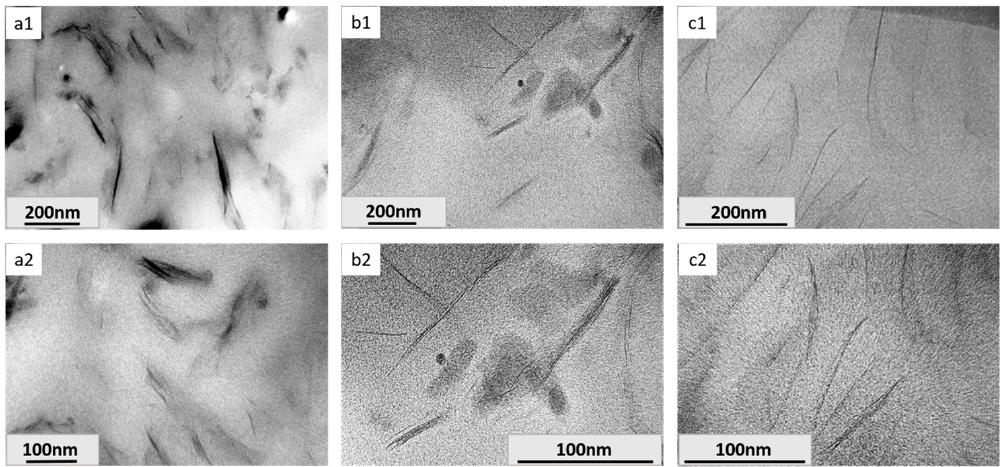
Figure 6. TEM images of epoxy matrix nanocomposites reinforced by Na-MMT ( a1 , a2 ), T5000-D400-MMT ( b1 , b2 ) and DDA-MMT ( c1 , c2 ) at 3 wt % clay loading.